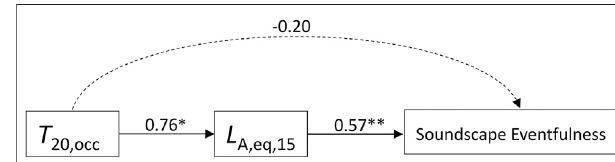
FIGURE 5 | Mediation analysis on acoustical parameters predicting soundscape eventfulness. Note: The estimates represent standardized regression coef fi cients β , and the asterisks indicate the signi fi cance of the respective effects, * p < 0.05, ** p < 0.01, as obtained by the SEM routine of the Lavaan Package in R/RStudio.